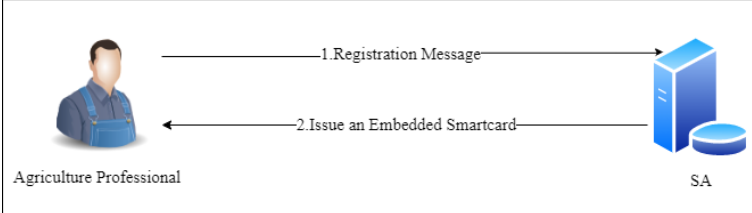
Figure 6. Agriculture professional registration phase.